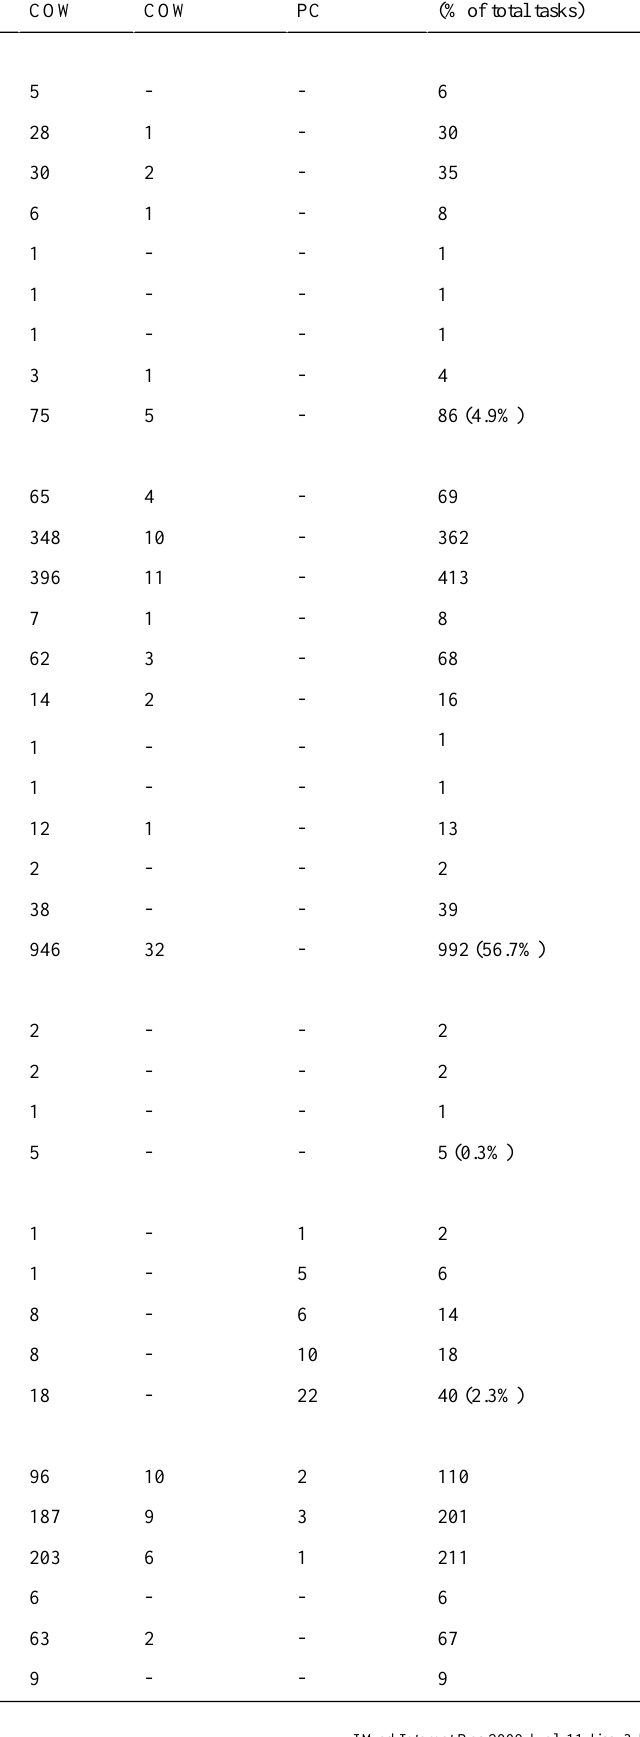
Table 2. Clinical tasks conducted by nurses by device and location of use (N = 1751 tasks)